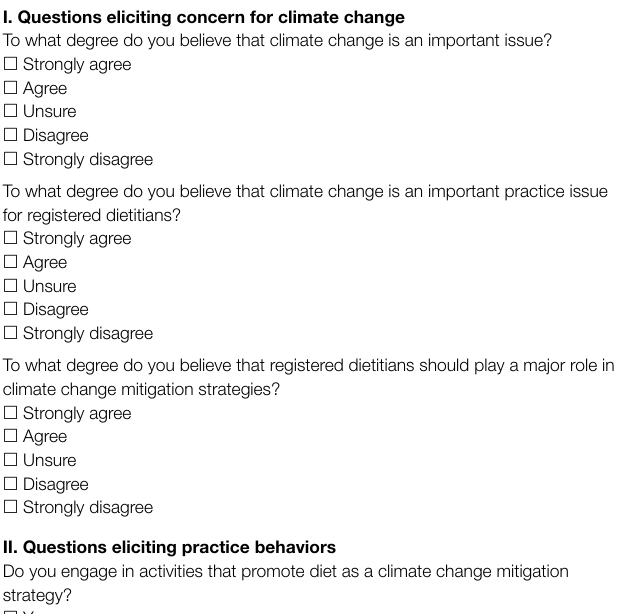
TABLE 1 | Examples of questions from the survey . I. Questions eliciting concern for climate change To what degree do you believe that climate change is an important